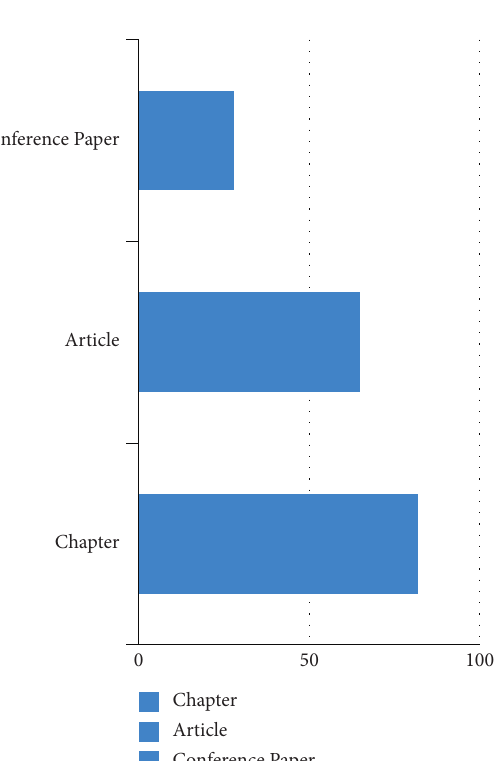
Figure 3: Papers details.